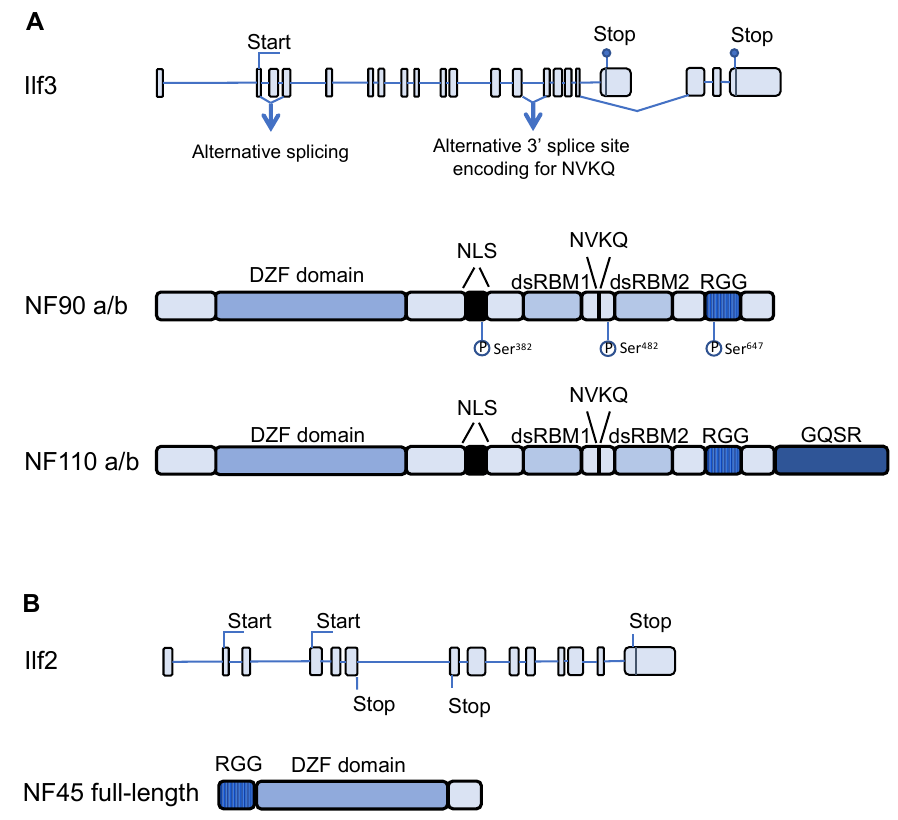
Figure 1. Schematic representation of ILF3 and ILF2 transcripts and domain structure of NF90, NF110, and NF45. ( A ). Isoforms of transcripts derived from the ILF3 gene showing alternative splicing sites and start and stop codons. Protein products of the ILF3 transcripts, NF90a/b and NF110a/b. Phosphorylation sites on NF90 are indicated. ( B ). Transcript derived from ILF2 gene showing start and stop codons. Protein product of ILF2 transcript, NF45. DZF indicates a zinc finger associated domain, NLS indicates nuclear localization signal, dsRBM1 indicates double stranded RNA binding motif 1, NVKQ indicates Asparagine-Valine-Lysine-Glutamine, dsRBM2 indicates double stranded RNA binding motif 2, RGG indicates Arginine-Glycine-Glycine repeats, and GQSR indicates the Glycine-Glutamine-Serine-Arginine